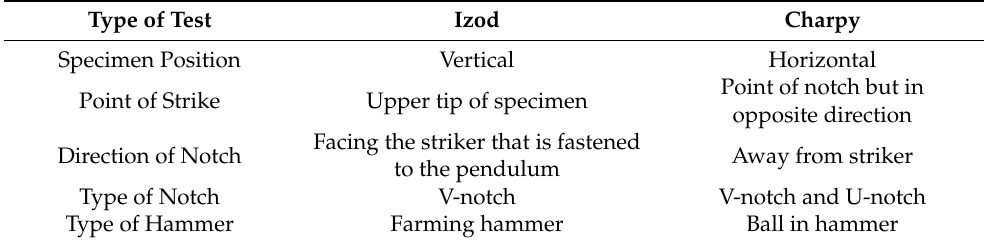
Table 8. Difference of Charpy and Izod Test adapted from [114] with permission from Akademia Baru, 2017. Type of Test Izod Charpy Specimen Position Vertical Horizontal Point of notch but in Point of Strike Upper tip of specimen opposite direction Facing the striker that is fastened Direction of Notch Away from striker to the pendulum Type of Notch V-notch V-notch and U-notch Type of Hammer Farming hammer Ball in